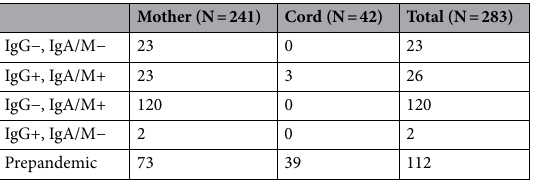
Table 1. Sample size and classification of samples according to their biological origin and ELISA